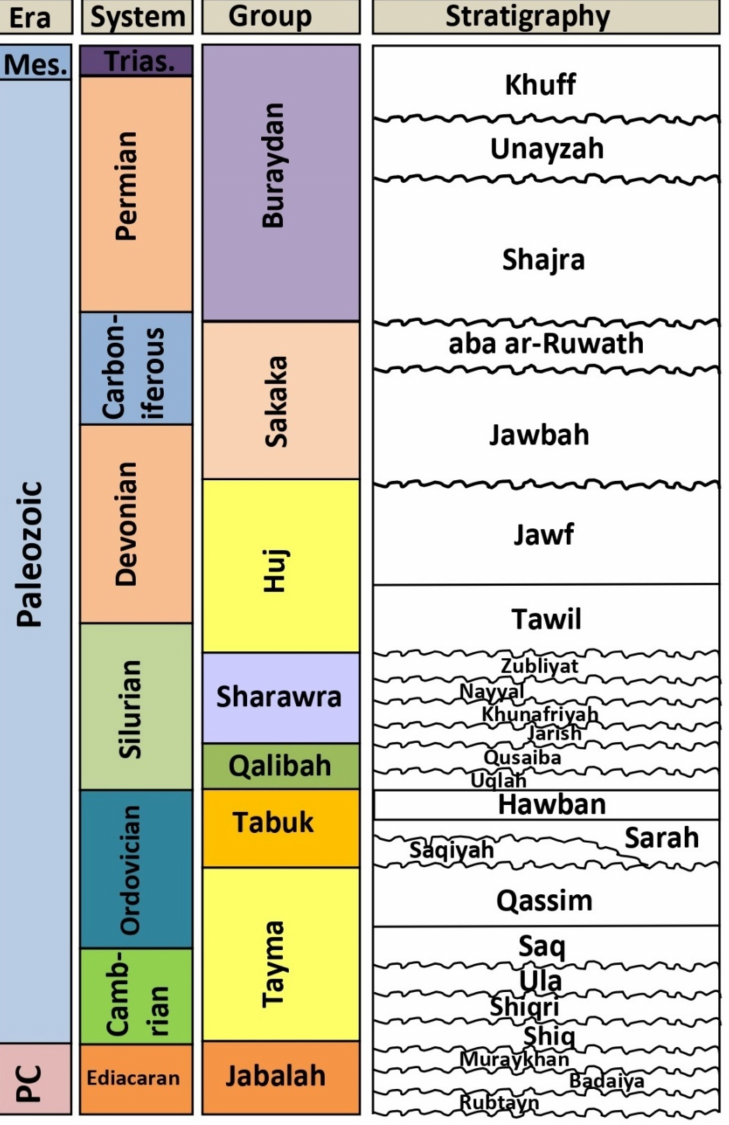
Figure 2. The stratigraphic column of the Paleozoic rocks at Tabuk and Widyan basins, northwestern Saudi Arabia (modified after